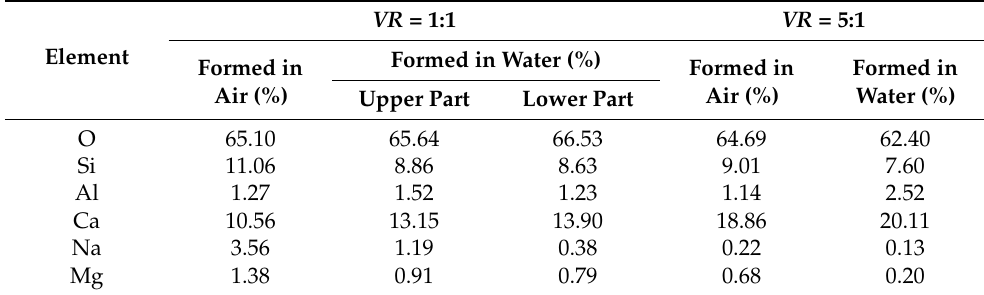
Figure 12. SEM images of CSG consolidation formed in water and air with a volume ratio of 5:1 ( × 3500). ( a ) CSG consolidation specimen formed in air; ( b ) CSG consolidation specimen formed in water. Table 3. The atomic percentage of chemical elements in the CSG consolidation obtained by EDS anal-